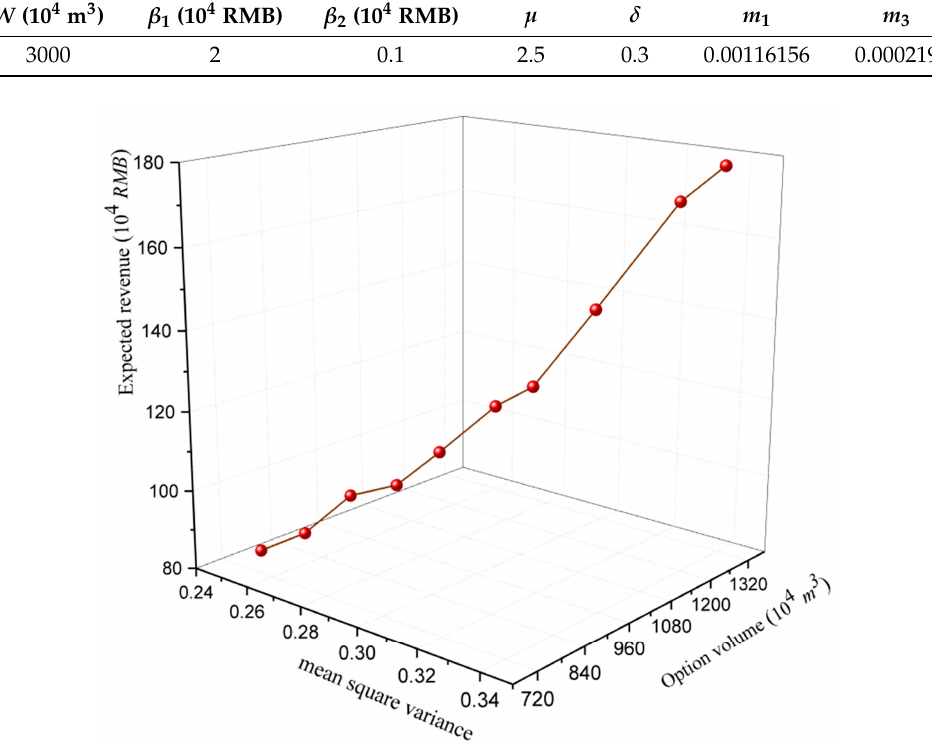
Figure 6. The relationship among the mean square variance, the optimal options trading volume and the expected revenue of the optimal options. Table 3. The results of experiment scheme 1.